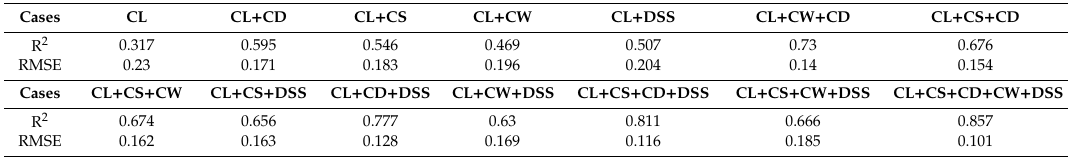
Table 3. Results of cases with stirrups and variables including corrosion level ( n = 109).